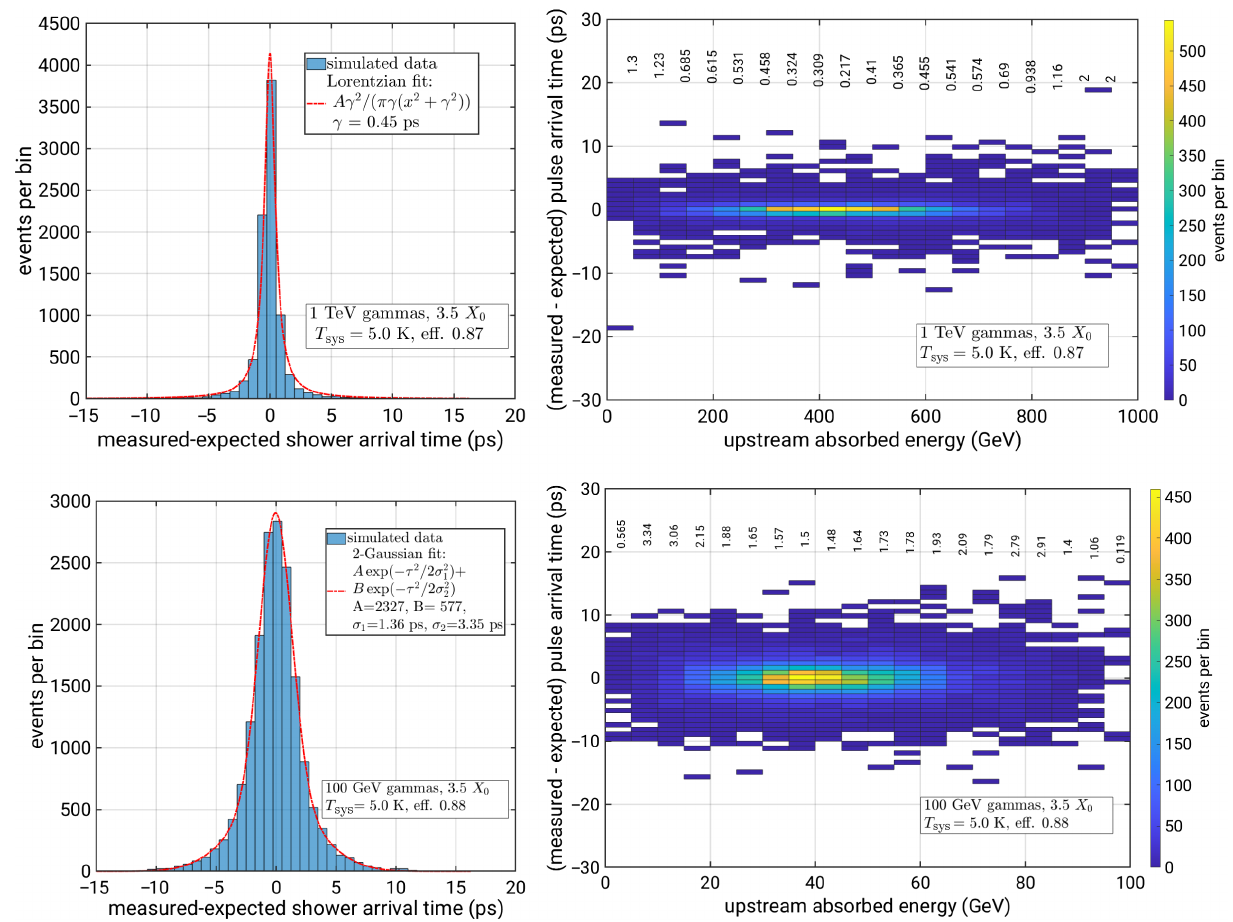
FIG. 26. Distributions of all times and time vs absorbed energy prior to the timing plane, for photons at 1 TeVand 100 GeV. Here our timing plane is between a preshower block and the forward EMCAL, with about 3.5 radiation lengths of material ahead of